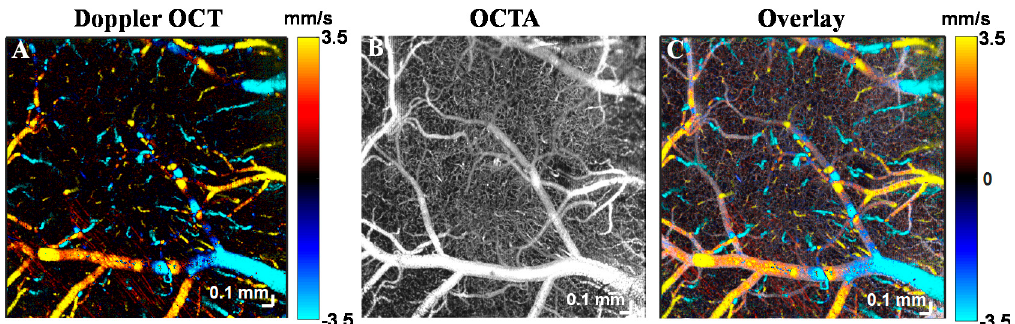
Figure 5. Doppler OCT and OCTA in the mouse brain. ( A ) Doppler OCT can visualize flow based on Doppler shifts, caused by motion in the axial direction, towards or away from the probe beam. On the other hand, OCTA visualizes flow based on decorrelation, usually caused by translational motion through the coherence volume, as well as Doppler shifts. The overlay of both methods ( C ) shows that Doppler OCT is mainly limited to ascending venules or descending arterioles, where Doppler shifts dominate. On the other hand, OCTA, which is sensitive to decorrelation, more comprehensively shows vasculature, including regions with predominantly transverse flow. A standard Kasai algorithm was used on transversally oversampled images for ( A ) and a complex interframe subtraction method was used on rapidly acquired repeated cross-sectional images for ( B ).